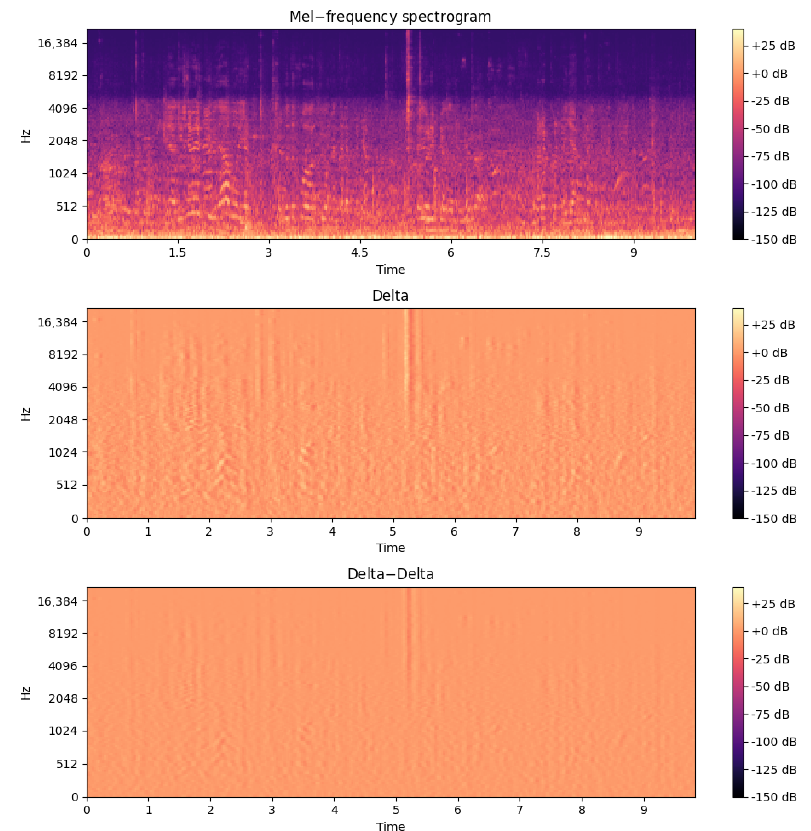
Figure 6. Sample spectrogram from the DCASE 2021 Task 1 Subtask A development dataset. This clip was recorded at an airport in Barcelona.The delta and delta-delta features are presented along with the spectrogram